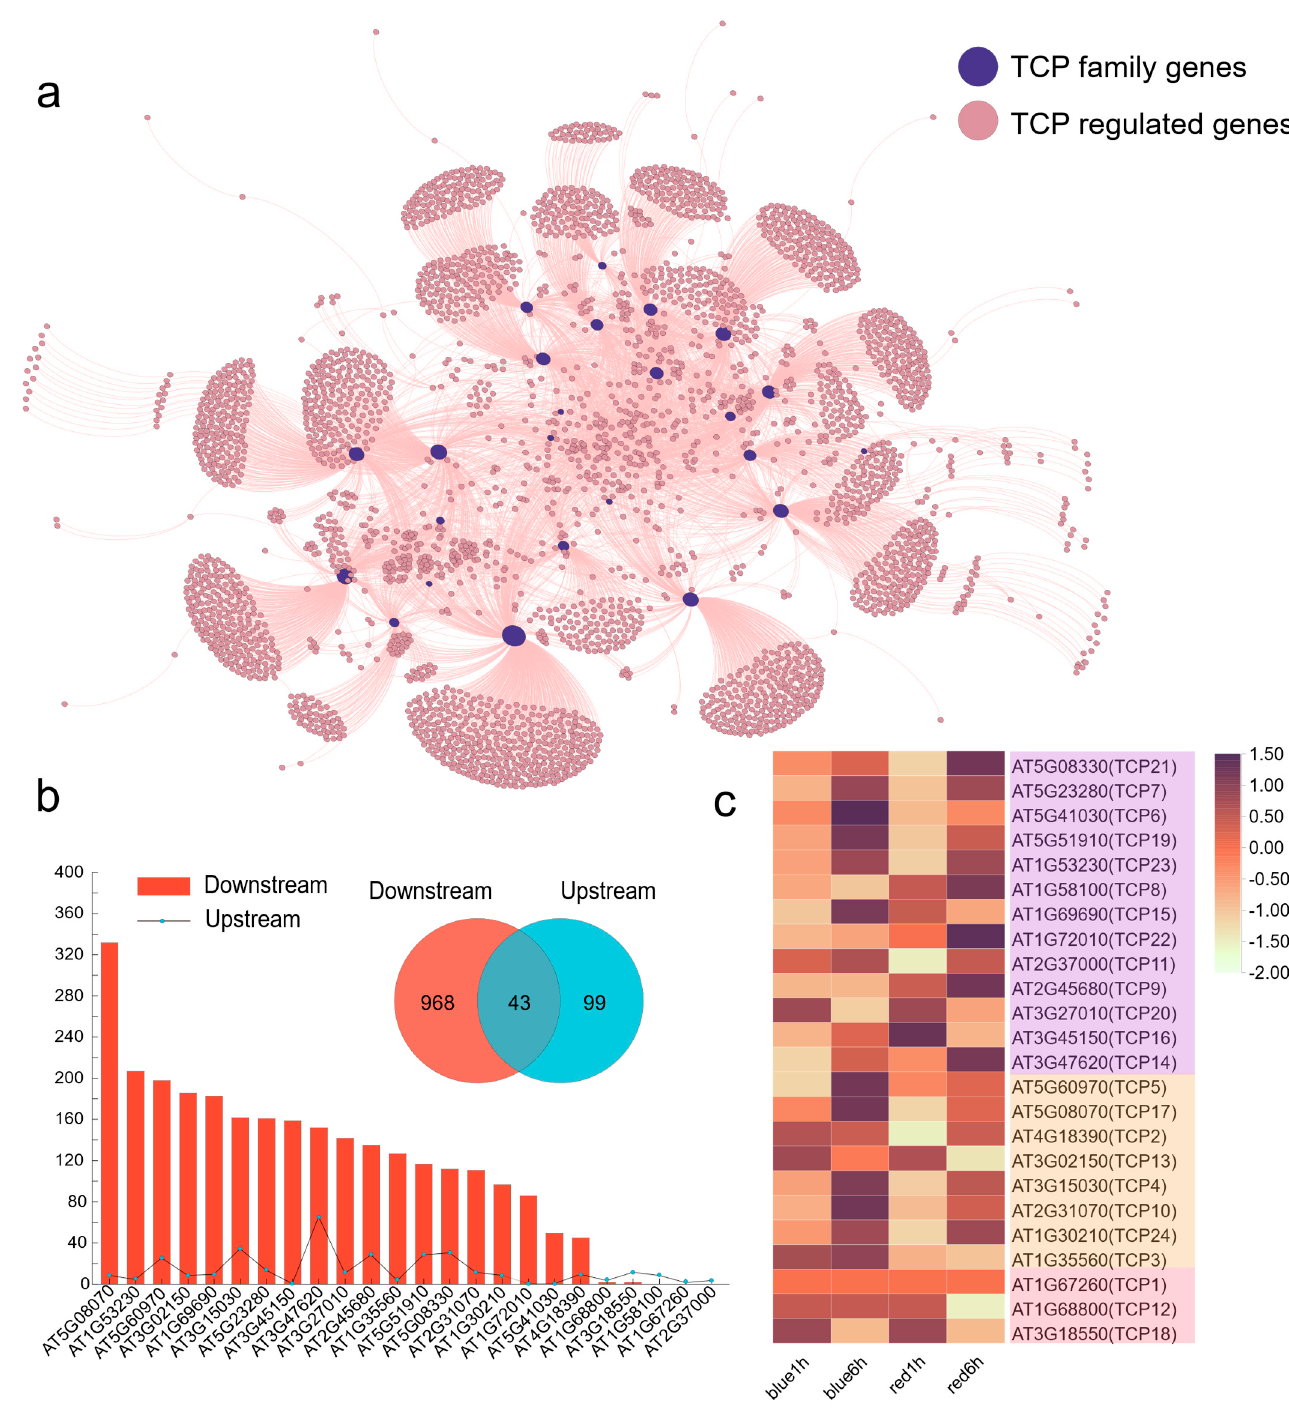
Figure 9. Interaction network between TCP family genes and their upstream and downstream regulatory genes in A. thaliana . ( a ): the network was constructed using gephi software; ( b ): the number of upstream and downstream genes for each TCP in the network; specific and common genes between downstream and upstream genes in the network; ( c ): expression profile of AtTCPs in Arabidopsis after red- and blue-light irradiation periods.